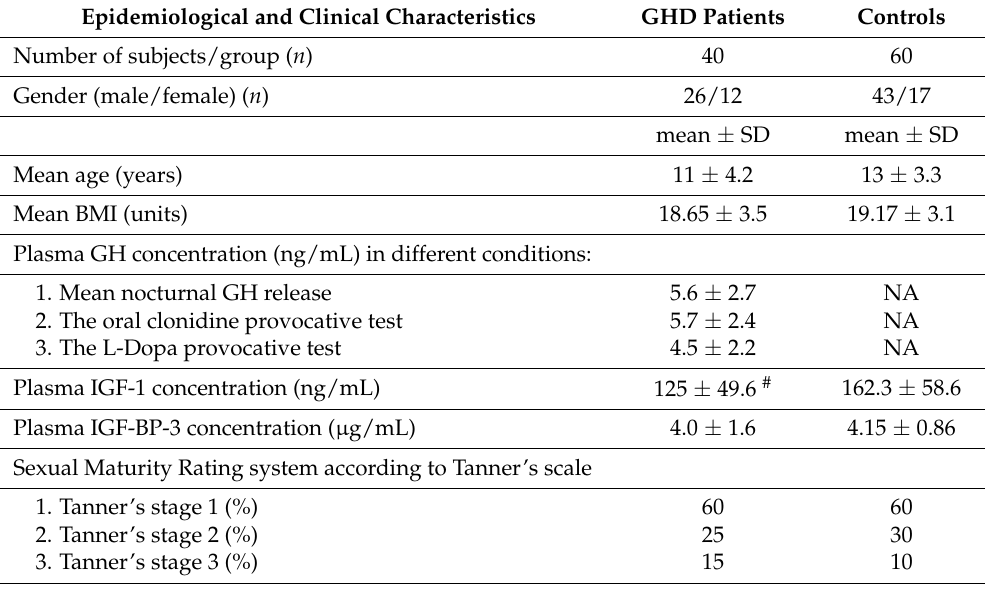
Table 1. Clinical characteristics of the study